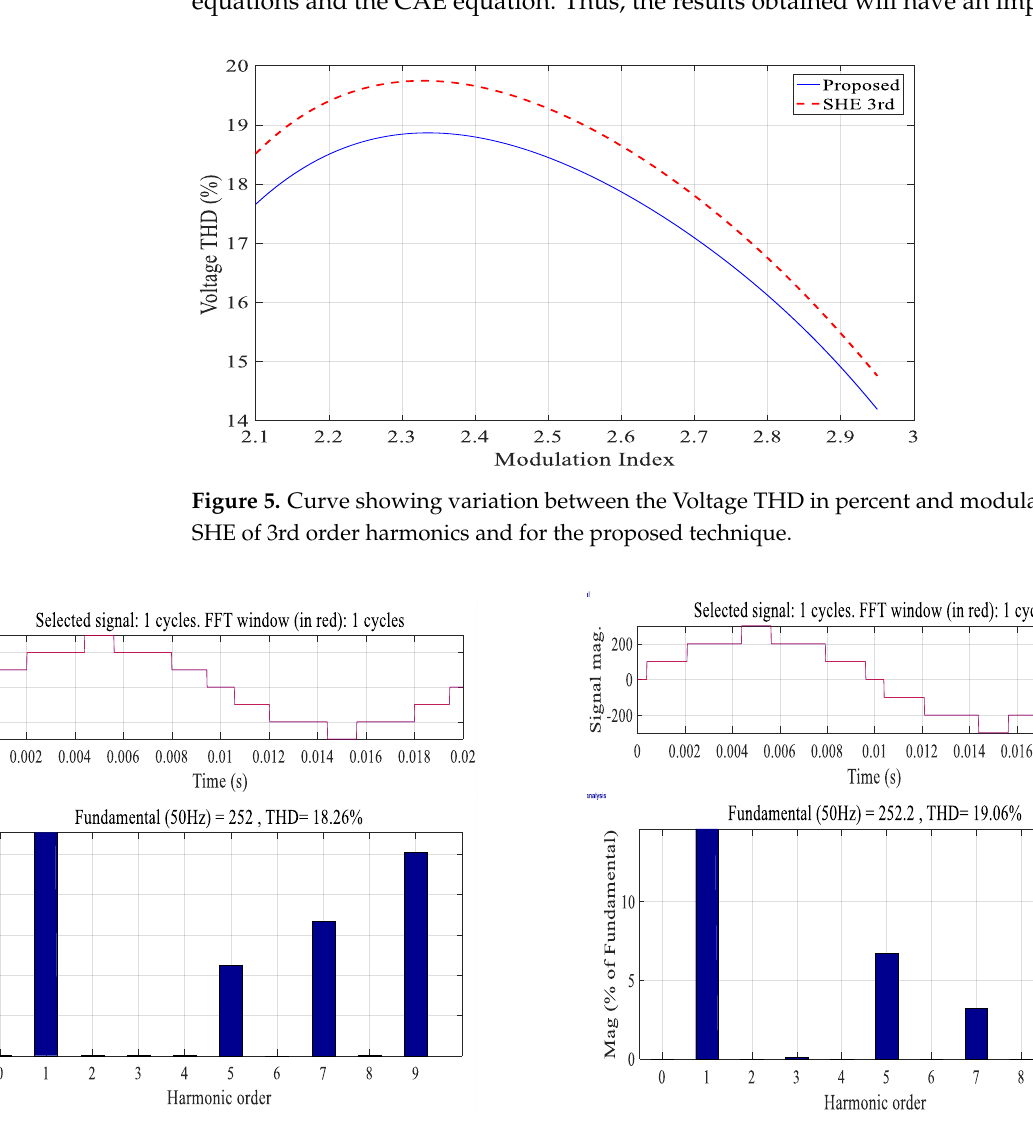
Figure 7. Curve showing variation between the estimated switching angles and modulation index for SHE of 3rd-order harmonics and the proposed technique. 3.2. Fifth Order Harmonic Elimination The proposed technique has a reduced output voltage THD over the restricted mod- ulation index, as depicted in Figure 8. From Figure 9, it is clear that the proposed technique is eliminating the 5th-order harmonics, along with reducing the THD of the output volt- age at selected operating points ( 𝑚 = 2.30). From Figure 9, at 𝑚 = 2.30 a natural cancella- tion of the 7th-order harmonic content can be observed, along with the cancellation of the target harmonic order in the case of the proposed technique. Additionally, it can be ob- served that the 3rd harmonic order has reduced significantly for the proposed technique, along with an increase in 9th-order harmonic content. This reduction in lower-order har- monic content other than the target harmonic has resulted in a significant reduction in THD of 3.90% for the proposed technique, in comparison to the conventional SHE tech- nique. Figure 10 shows the variation in the estimated switching angle for the proposed and conventional 5th-order harmonic elimination techniques mentioned. From Figure 10, it can be seen that there is no overlap for any of the switching angles at any operating points. Except for switching the angle 𝛽 3 , the other switching angles are less for the pro- posed technique than compared to the conventional SHE.